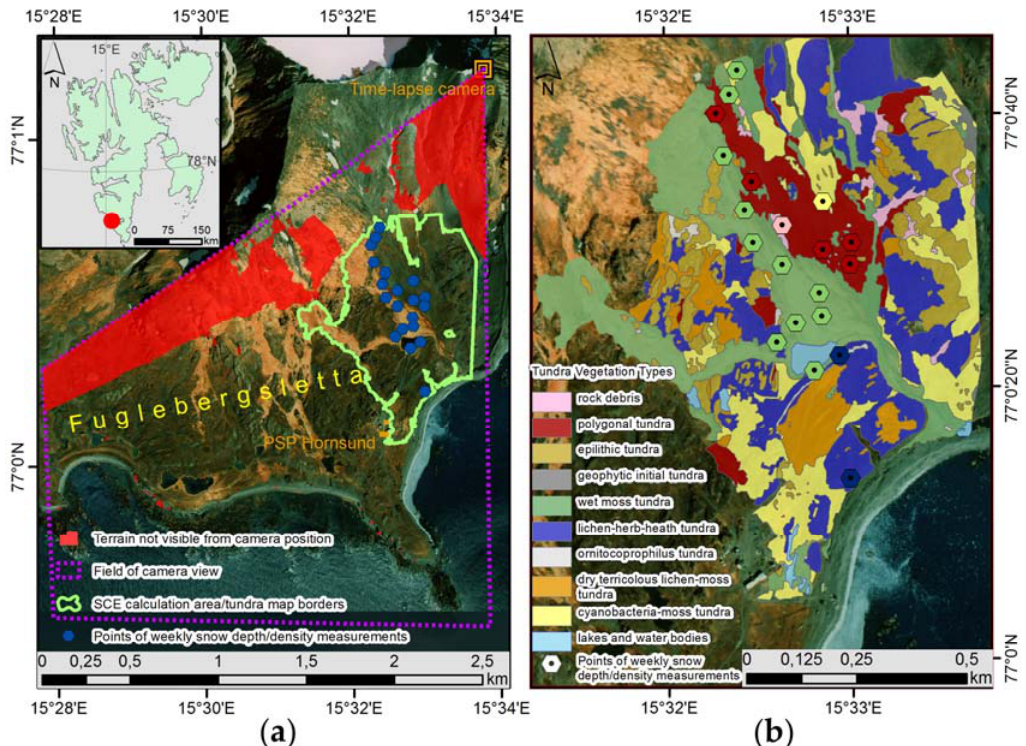
Figure 1. Location of the study area. ( a ) Overview with denoted extent of the camera view and the polygon used as the classification mask. ( b ) Zoom to the classification area with superimposed vegetation map. The detailed characteristics of specific plant communities are described in Wojtu ń et al. 2013 [42].